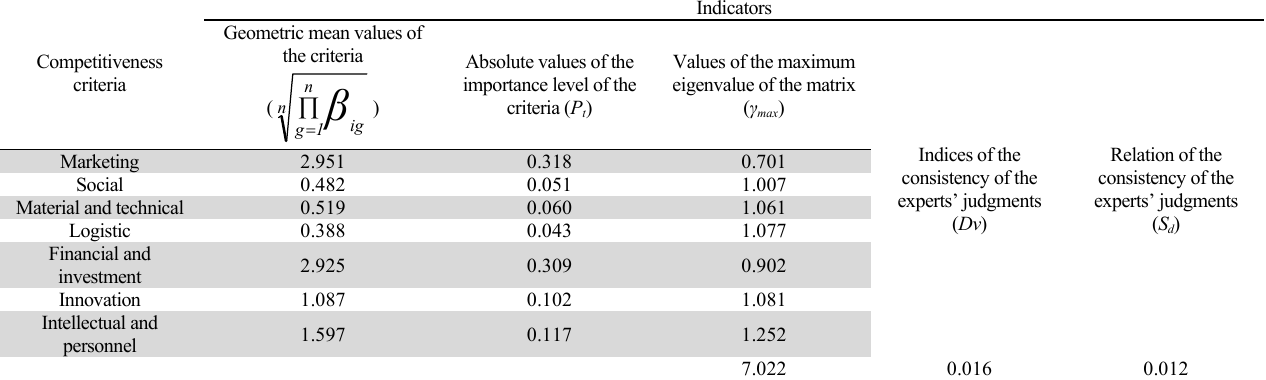
Results of assessing the importance level of the “local vectors” in ensuring the retailers’ competitiveness Competitiveness